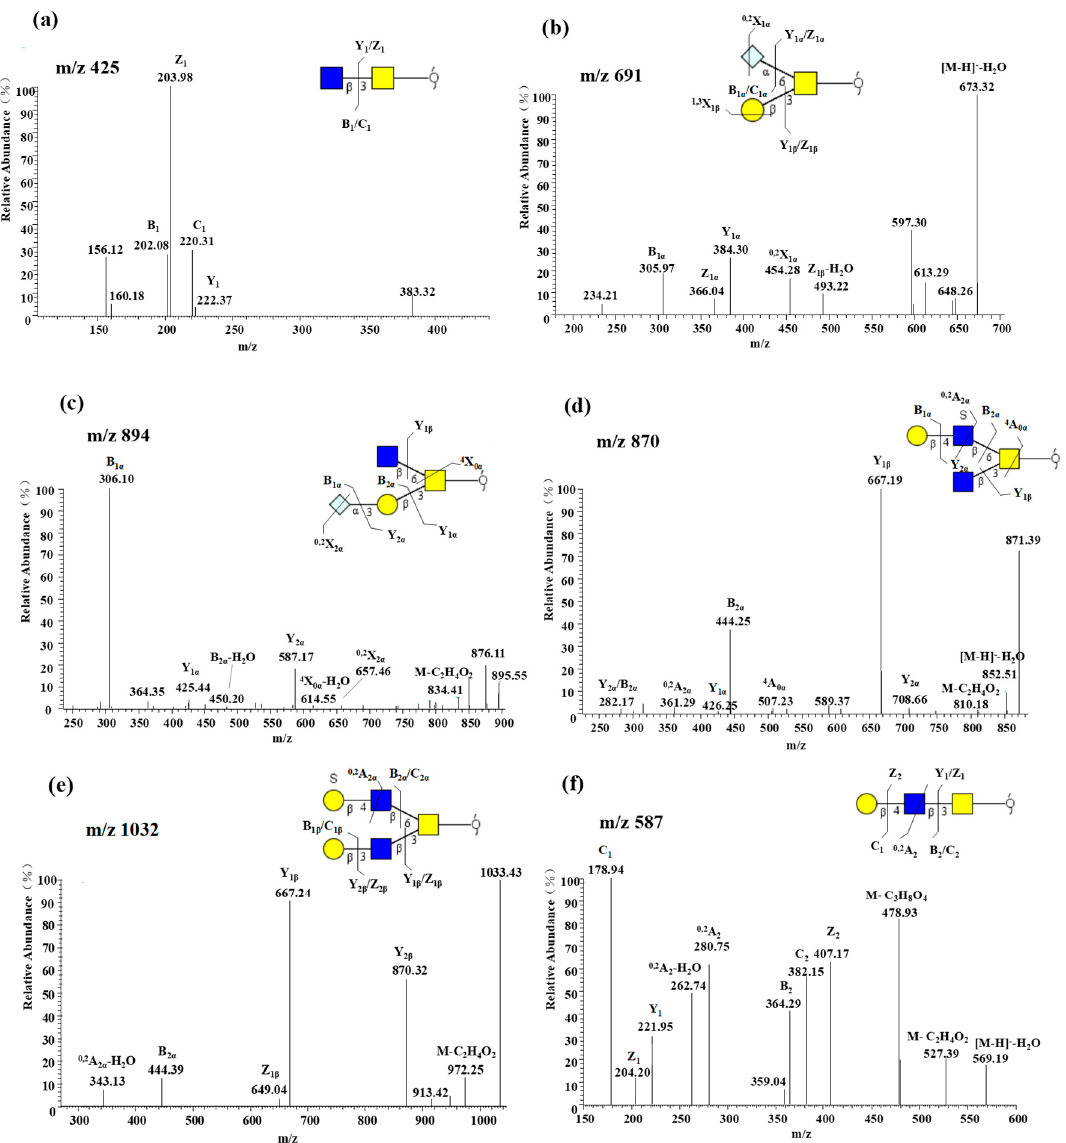
Figure 2. MS/MS spectra in the negative ion mode and proposed fragmentation of O -glycan with different core types and two isomeric oligosaccharides: ( a ) core 3 oligosaccharide at m / z 425 [GlcNAc β 1-3GalNAc-ol]; ( b ) core 1 oligosaccharide at m / z 691 [Gal β 1-3(Neu5Gc α 2-6)GalNAc-ol]; ( c